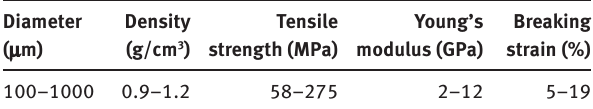
Table 2: Mechanical properties of DPF [2, 5, 7, 8].